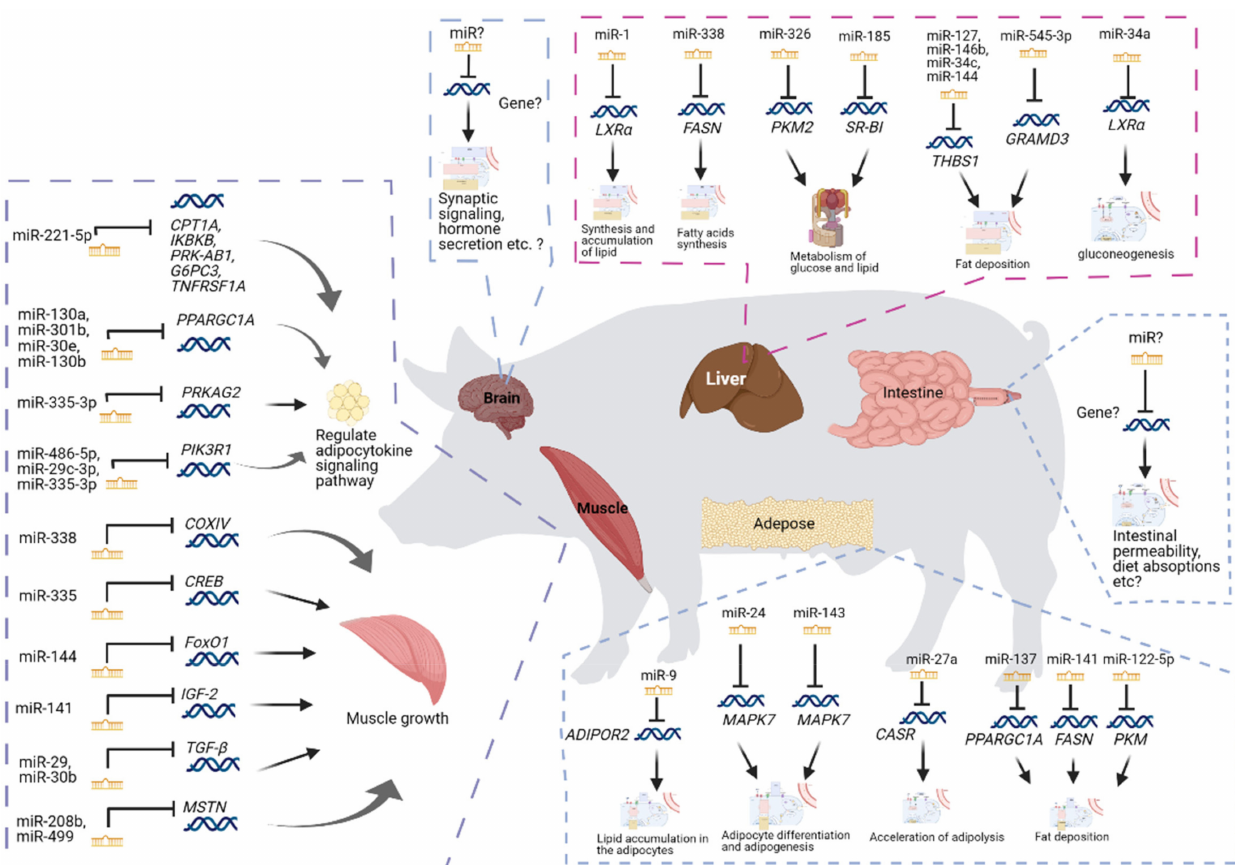
Figure 1. The miRNAs in pig feed efficiency. This figure was created with BioRender.com